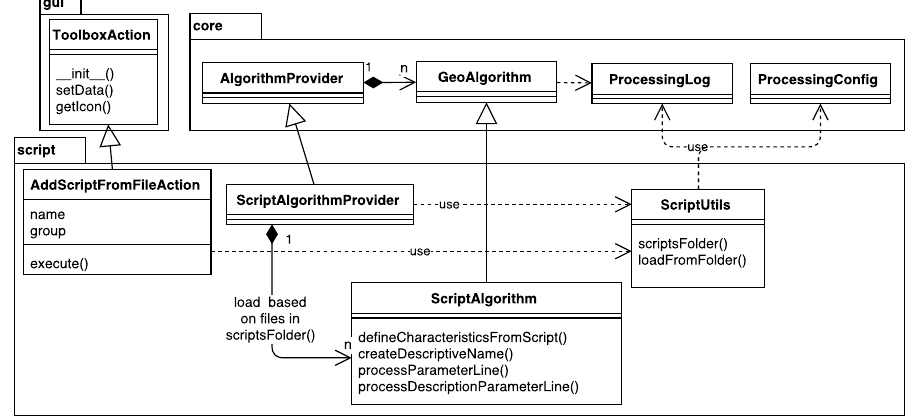
Figure 15. Class diagram of the script package and its connections to other packages.